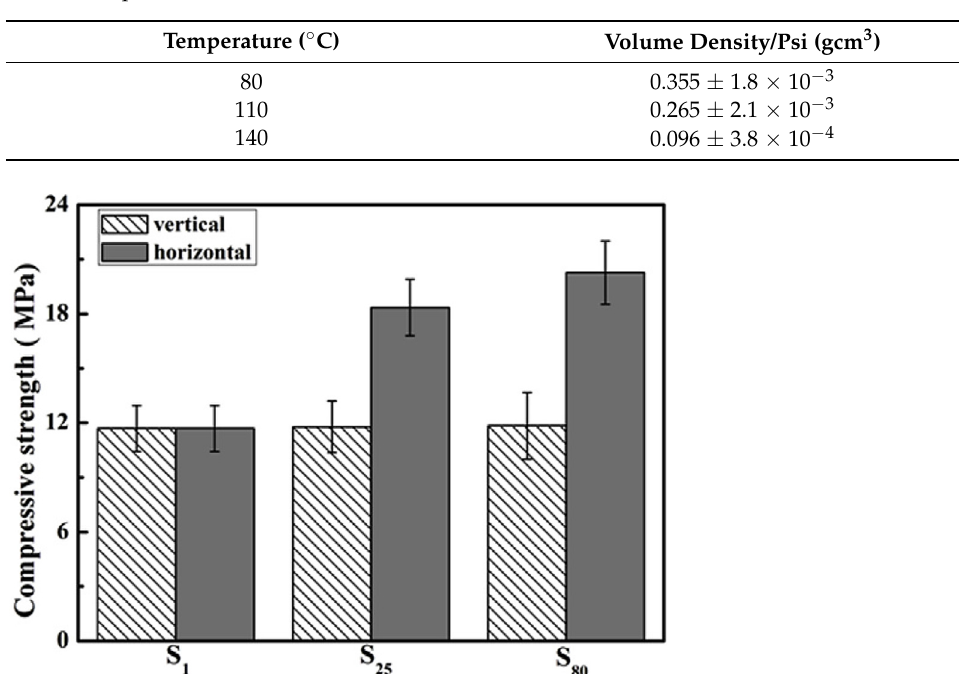
Figure 3. Compressive strength of foams (foaming at 16 MPa and 80 °C) [47]. The single layer PMMA sheet, 25 multi-layer PMMA sheet, and 80 multi-layer PMMA sheet were named as S1, S25, and S80, respectively. Reproduced with permission from Elsevier.